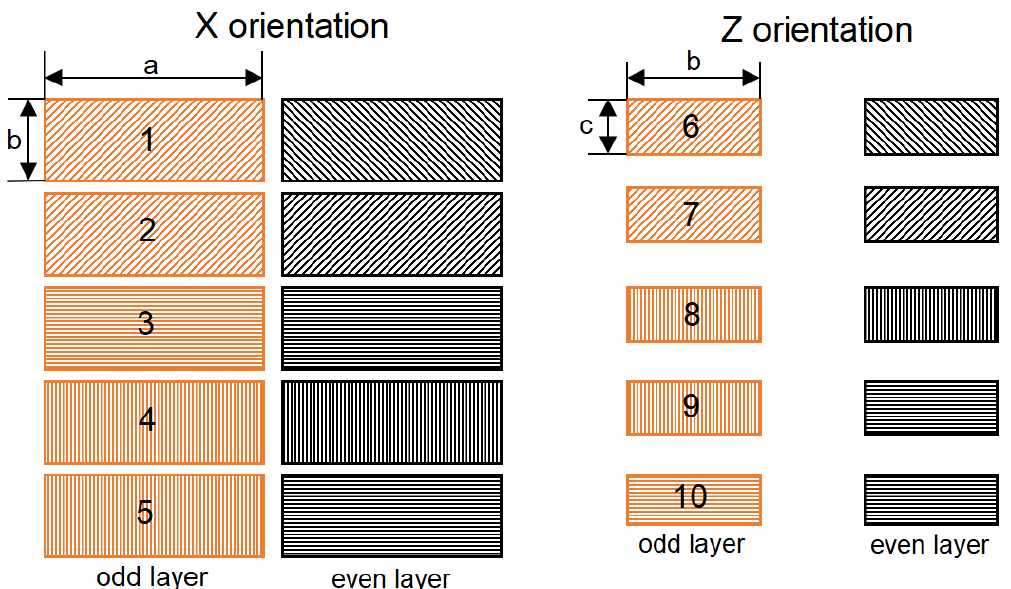
Figure 4. Samples 1 – 5 diagram and Samples 6 – 10 diagrams (building orientation). Dimension a, b Figure 4. Samples 1–5 diagram and Samples 6–10 diagrams (building orientation). Dimension a, b and c according to Figure 1. and c according to Figure 1.